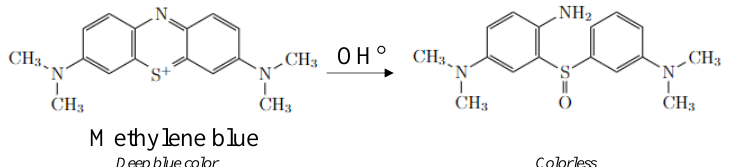
Figure 7. Opening of the central aromatic ring of an MB molecule after electrophilic attack of OH ◦ on the free doublet of heteroatom S.